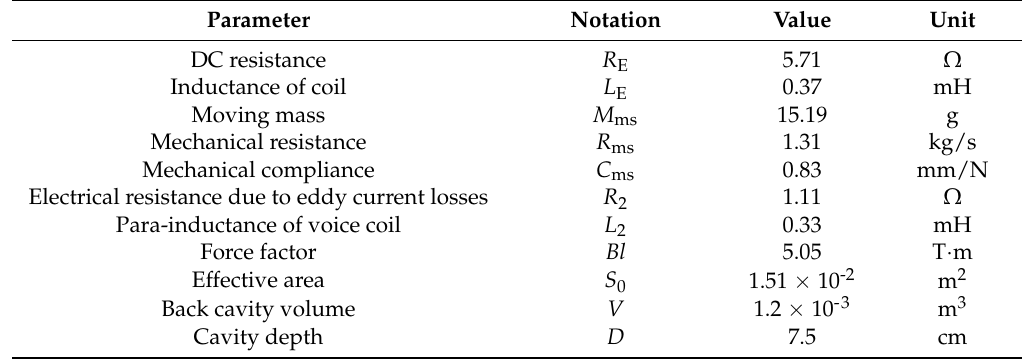
Table 4. Measured TS parameters and dimensions of a closed-box loudspeaker (SL 2 unit).